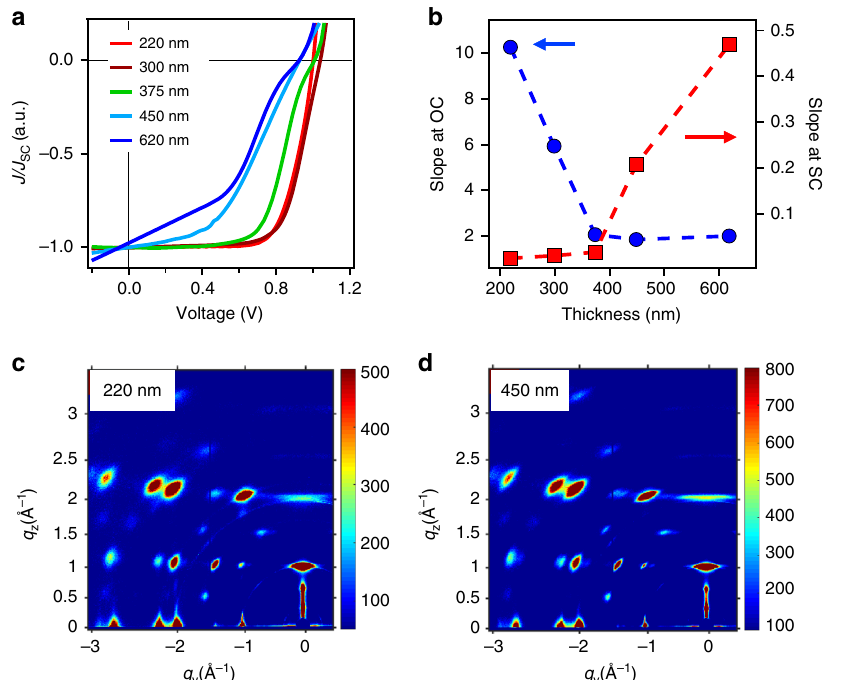
Fig. 2 J – V characteristic curves for solar cells with different absorber thicknesses. a J – V curves normalized by J SC for various thicknesses from Fig. 1b. b The J – V slope obtained by taking the fi rst-order derivative from a at OC (red) and SC (blue). c , d GIWAXS map for Pb